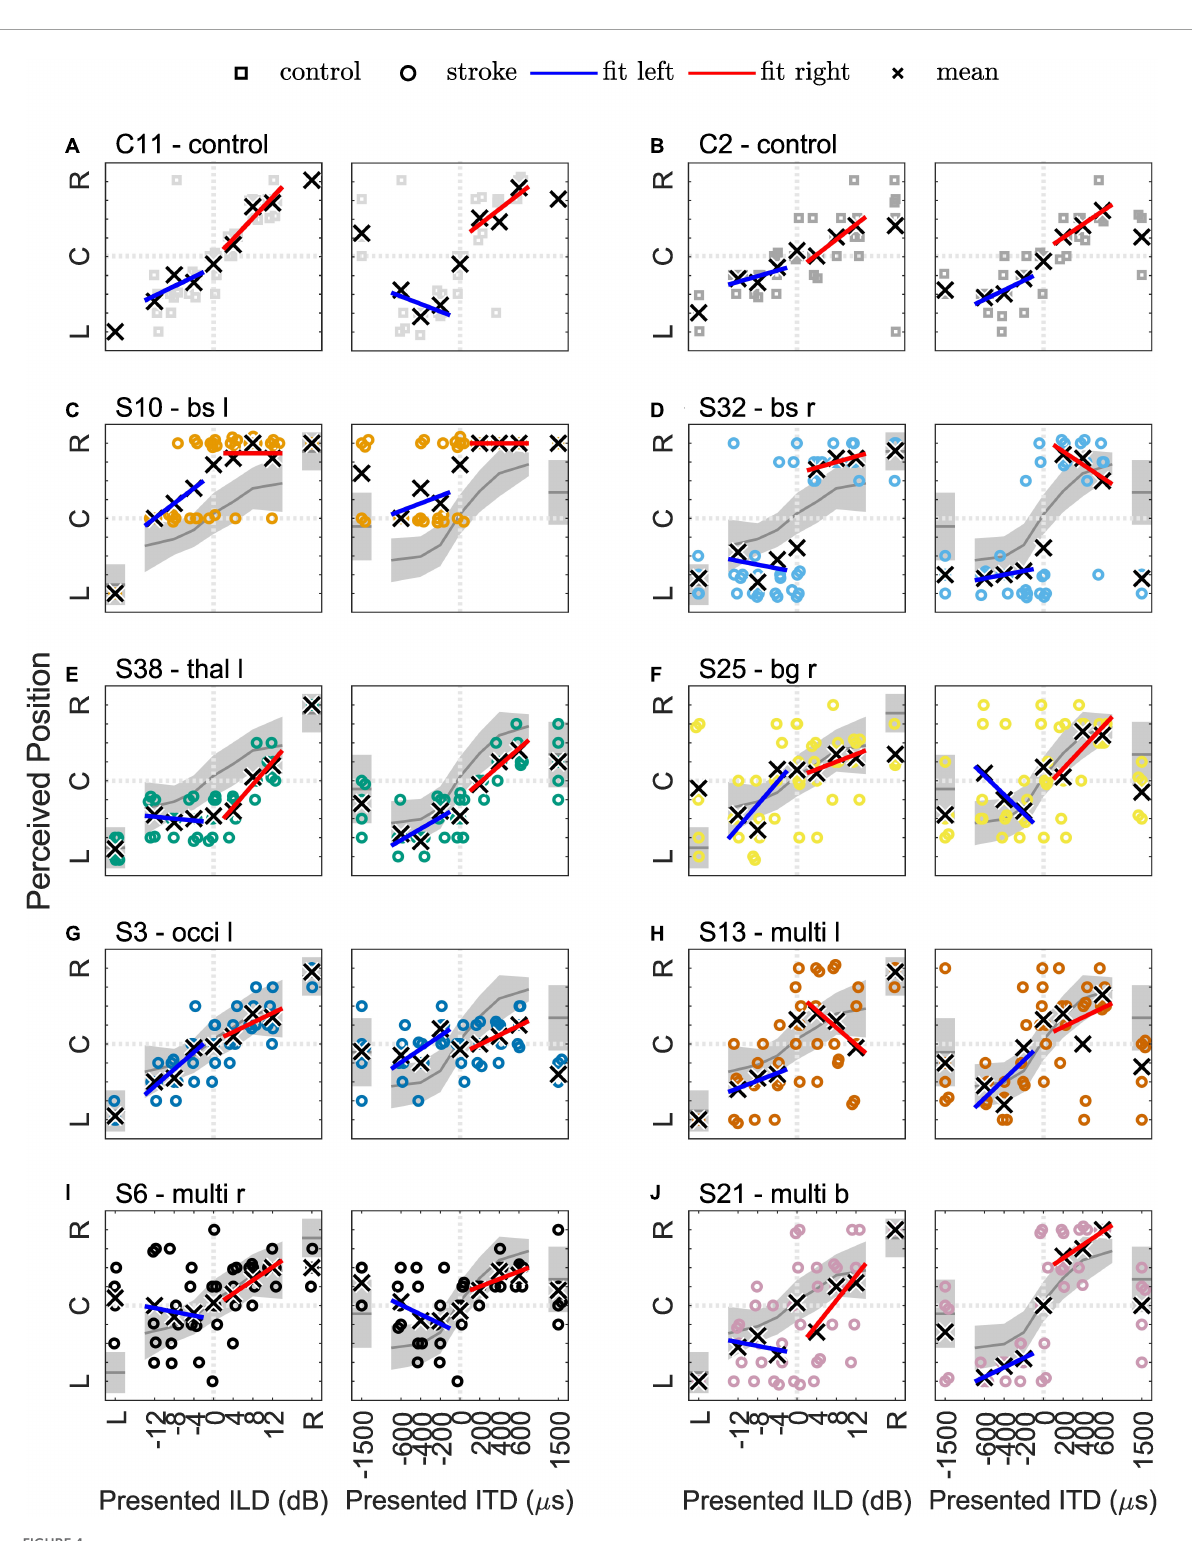
FIGURE4 Results of the lateralization task for two example control subjects in panels (A,B) and eight selected stroke patients in panels (C–J) . The colored symbols represent the responses given to the individual trials of the same stimulus, except for the discarded first trial. The black crosses indicate the means of the given responses. The red and blue lines represent linear fits to right-favoring and left-favoring stimuli, respectively. The gray line and shaded area in panels (C–J) indicate the mean and the 1.5 times standard deviation interval around the mean response of the control